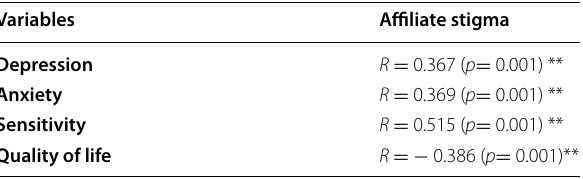
Table 4 Correlation between affiliate stigma and depression, anxiety, sensitivity, and quality of life in caregivers of ADHD and ASD children